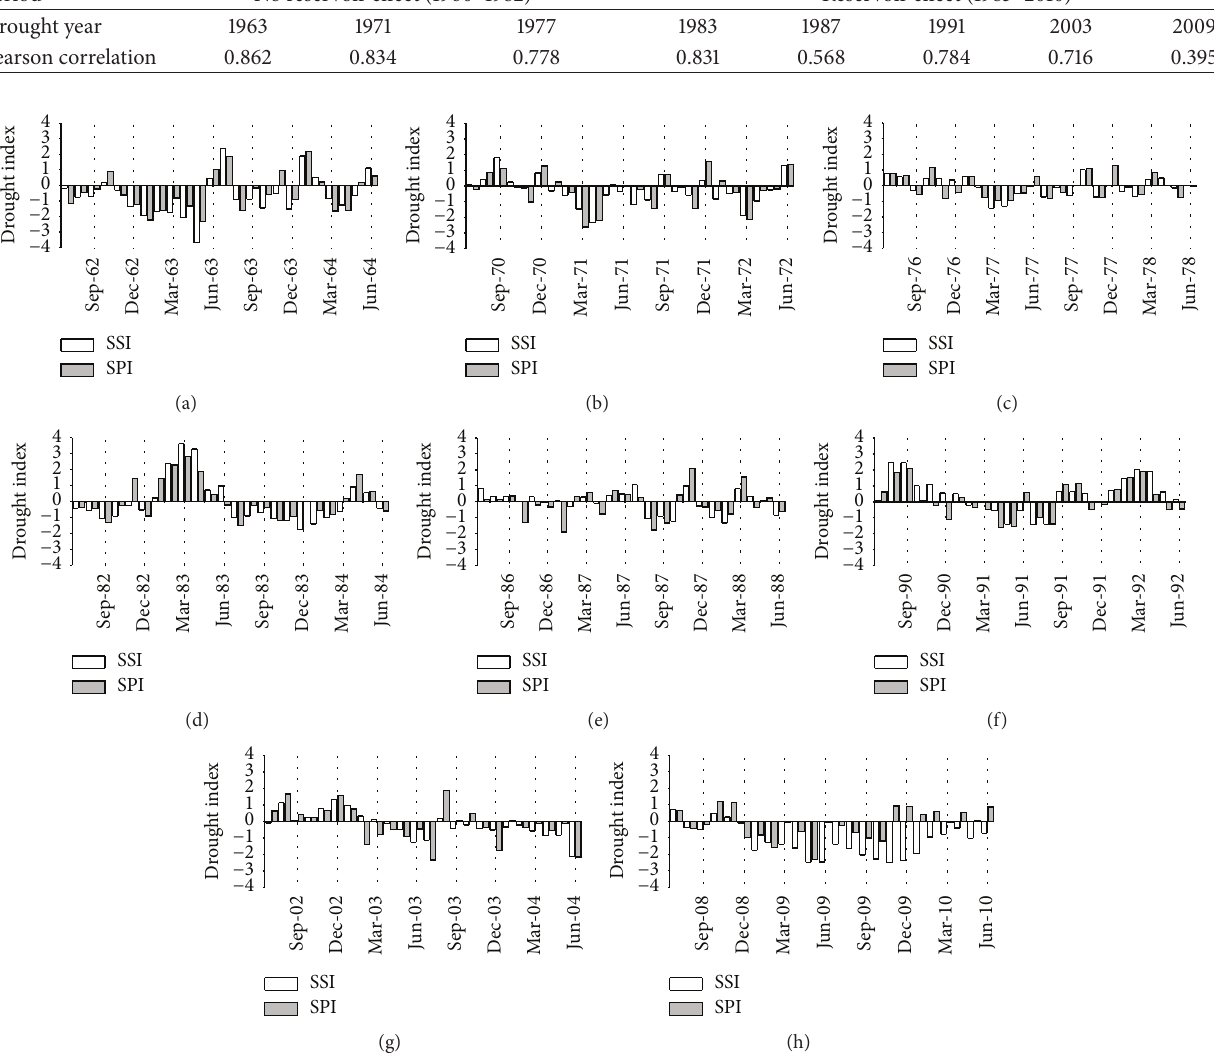
Figure 6: Typical drought years of monthly evolution: (a) 1963, (b) 1971, (c) 1977, (d) 1983, (e) 1987, (f) 1991, (g) 2003, and (h)